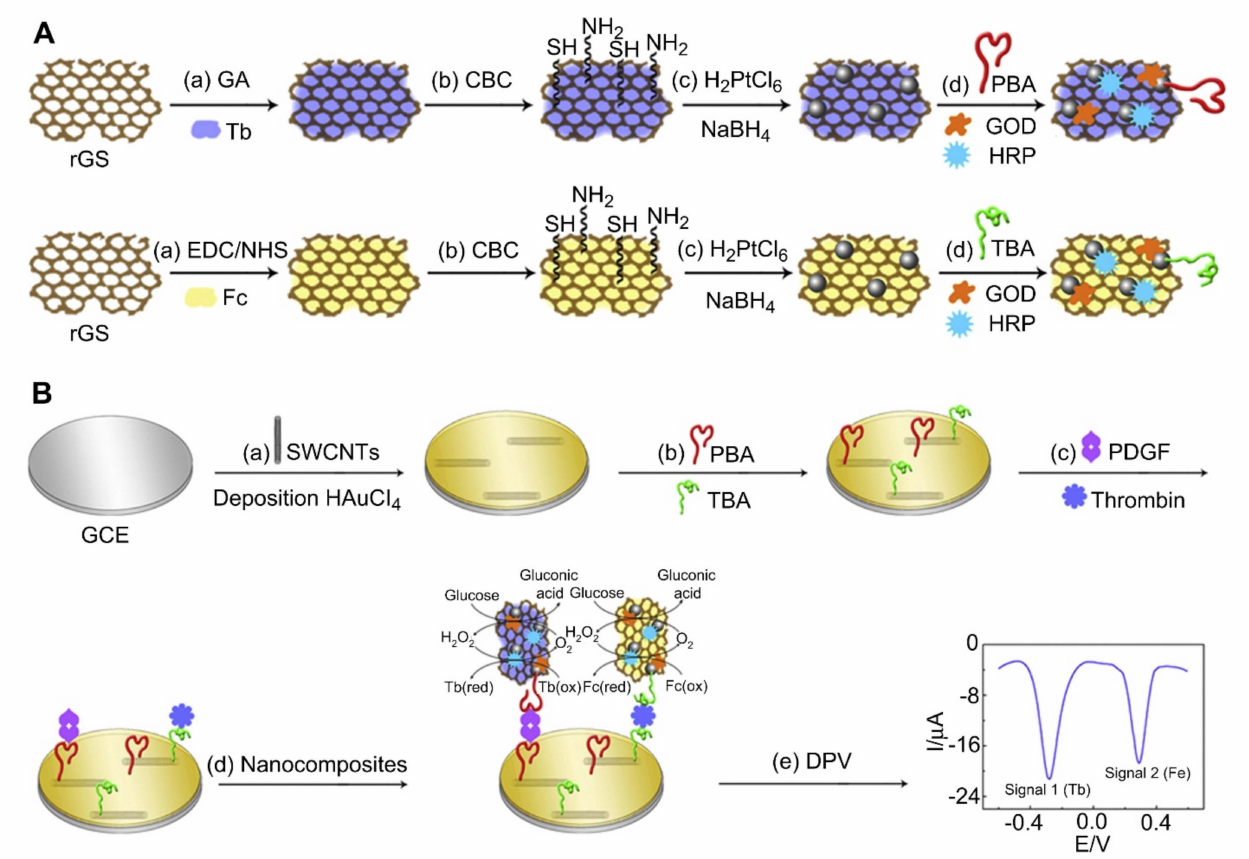
Figure 5. ( A ) The illustration of nanocomposites preparation steps based on aptamers, GOD, and HRP multi-labeled PtNPs-redox probes-rGS, and ( B ) the fabrication process of the stepwise aptasensor and differential pulse voltammogram of current response toward PDGF and thrombin (reprinted with permission from Bai et al.